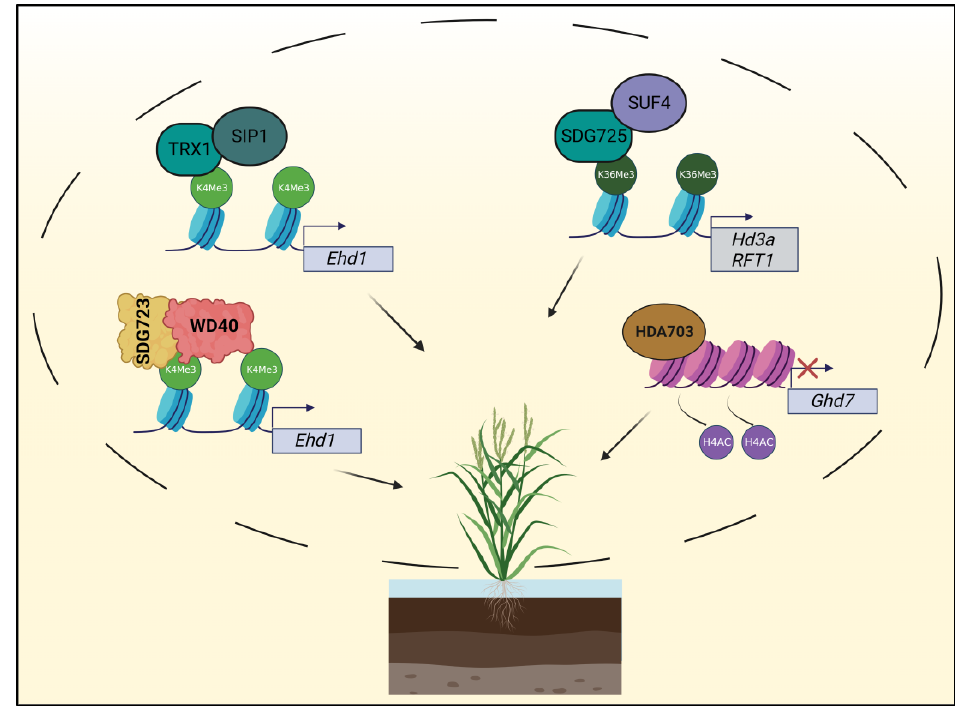
Figure 1. Overview of the histone modifications regulating flowering initiation in rice: TRX1 (TRITHORAX-like protein 1) interacts with SIP1 (SDG723/OsTRX1/OsSET33 Interaction Protein 1) to promote H3K4me3 deposition on the Ehd1 ( Early heading date 1 ) locus, thereby inducing flowering; the COMPASS complex that includes WD40 and SDG723 (Set Domain Group protein 723) positively induces flowering and panicle branches by increasing H3K4me3 levels on Ehd1 promoter. SUF4 (SUppresor of Fri 4) mediates H3K36me3 on Hd3a ( Heading date 3a ) and RFT1 ( Rice Flowering Time Locus T1 ) promoters by interacting with histone methyltransferase SDG725. Conversely, histone deacetylase HDA703 deacetylates histone H4 (see histones in purple) on the Ghd7 ( Grain number, plant height, and heading date7 ) locus, thereby promoting the transcriptional activation of Ehd1 .